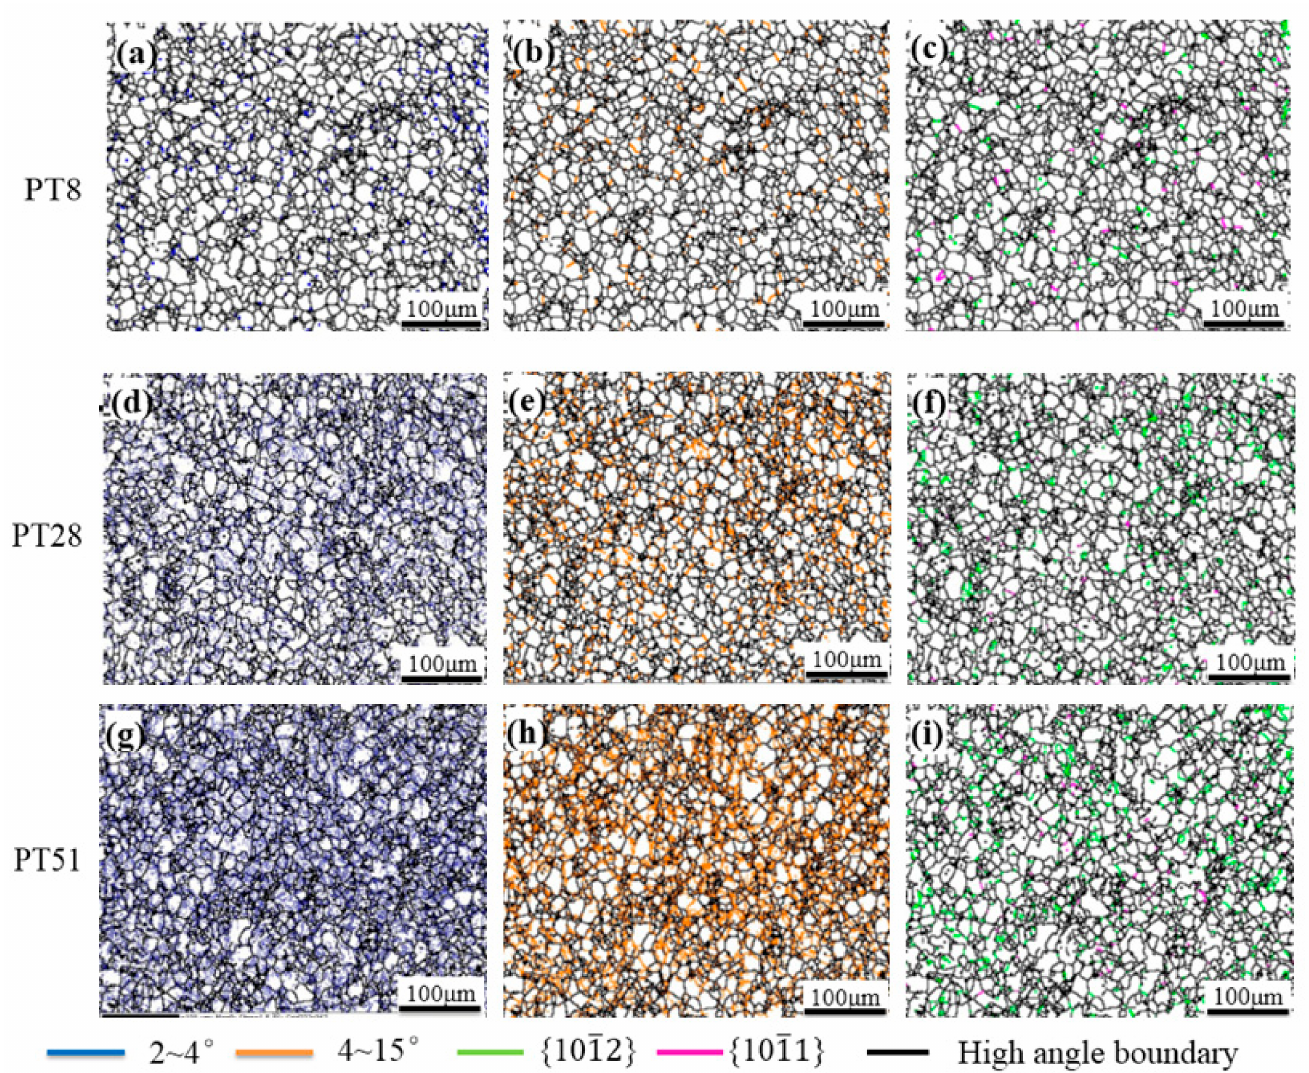
Figure 4. Boundary distributions of the twisted samples in the edge region ( a – c ) PT8, ( d – f ) PT28, ( g – i ) PT51. ( a , d , g ) for